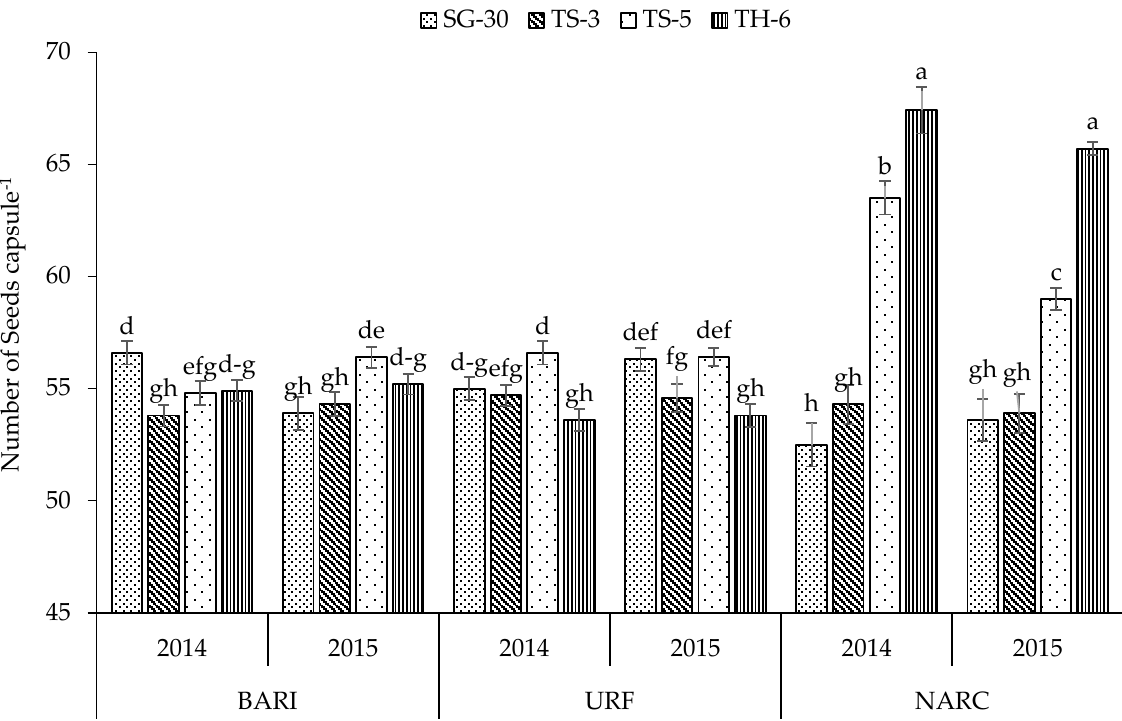
Figure 7. Number of seeds capsule − 1 of four sesame cultivars at three locations during 2014 and 2015 (pooled over micronutrients). The bars indicates standard error ( ± SE) of mean (n = 3). All means are significantly different at p ≤ 0.05.